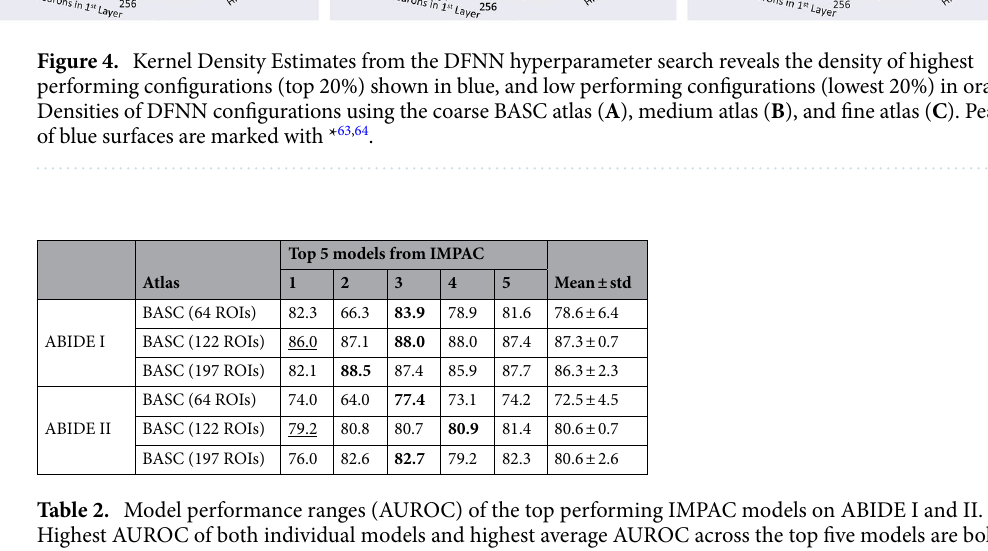
Table 2. Model performance ranges (AUROC) of the top performing IMPAC models on ABIDE I and II. Highest AUROC of both individual models and highest average AUROC across the top five models are bolded.